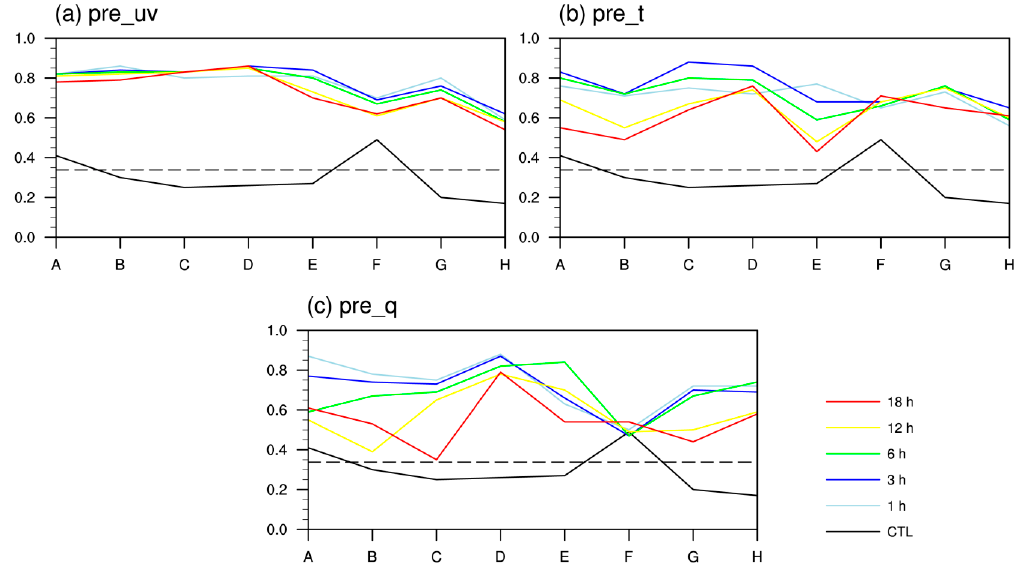
Figure 5. The variation of the correlation coefficient (CC) between the simulated and observed precipitation in sub-regions A–H when various nudging times were adopted (the dashed line indicates the CC threshold passing significance t test at 0.1% significance level): ( a ) nudging uv; ( b ) nudging θ ; and ( c ) nudging q.